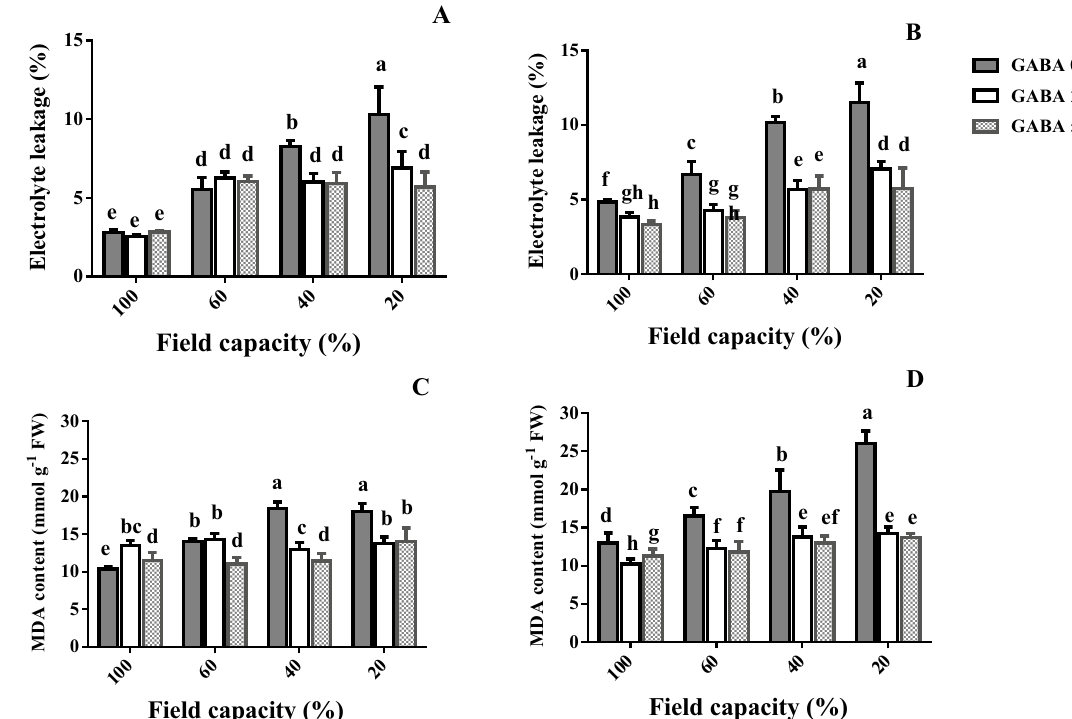
Figure 7. Leaf electrolyte leakage ( A , B ) and malondialdehyde (MDA) content ( C , D ) of cv. Arman (tolerant; left panels) and cv. Azad (sensitive; right panels) chickpea plants receiving exogenous application of γ-aminobutyric acid (GABA) at different concentrations (0, 25 and 50 μM) under different watering levels (100, 60, 40 and 20% field capacity) during cultivation. Within each insert, different letters indicate significant differences. Error bars indicate SEM (n = 3). FW fresh